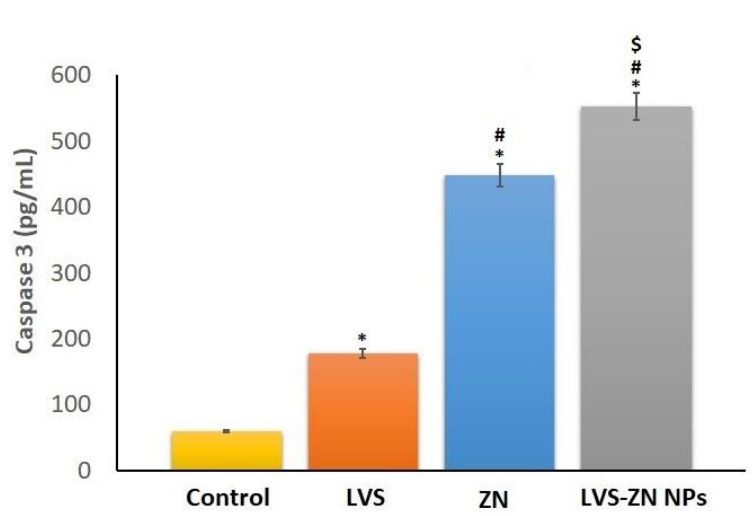
Figure 8. Impact of LVS-ZN NPs on caspase 3 enzyme concentrations in HepG2 cells. * Significantly di ff erent ( p < 0.05) compared to the control. # Significantly di ff erent ( p < 0.05) compared to LVS. $ Significantly di ff erent ( p < 0.05) compared to